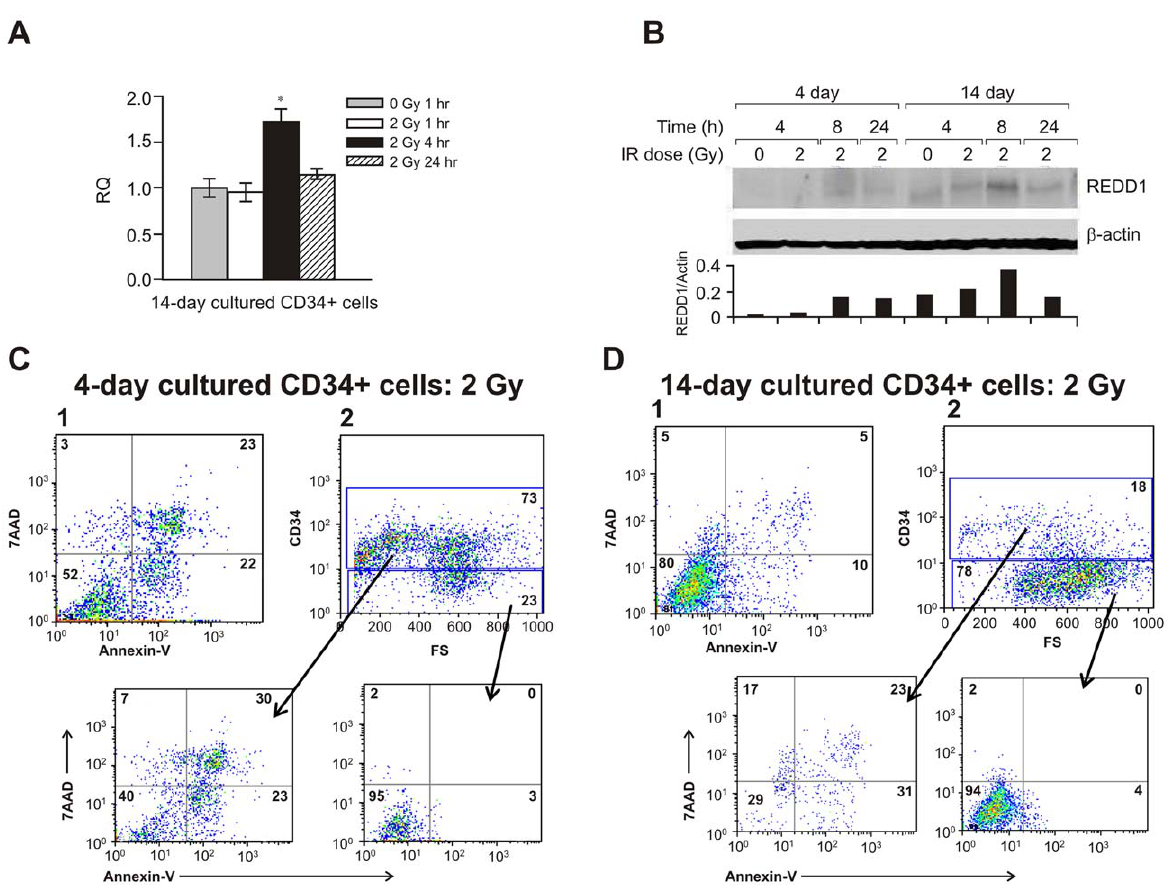
Figure 3. REDD1 expression in human hematopoietic cells. Purified human CD34 + cells were cultured for 4 and 14 days before being exposed to 2 Gy radiation. (A) mRNA levels for REDD1 in 14-day cultured CD34 + cells using 18S rRNA as a control to calculate the relative quantity (RQ) of gene expression at different times after IR. Means 6 SD. *, p , 0.05, 2 Gy vs. 0 Gy sham-irradiated control. (B) Western blot shows REDD1 protein levels in cultured CD34 + cells at different times after 2 Gy irradiation. Representative immunoblots and ratio of REDD1/ b -actin expression from 3 independent experiments are shown. Flow cytometric analysis for the apoptotic cell death marker Annexin-V/7AAD and CD34 surface marker was performed. Radiation resulted in more apoptotic cells in 4-day (C-1) cultured cells than in 14-day (D-1) culture. (C-2) and (D-2) CD34-positive (progenitor) and CD34-negative (mature) populations were separately gated for Annexin-V/7AAD analysis. FS, forward angle light scatter.